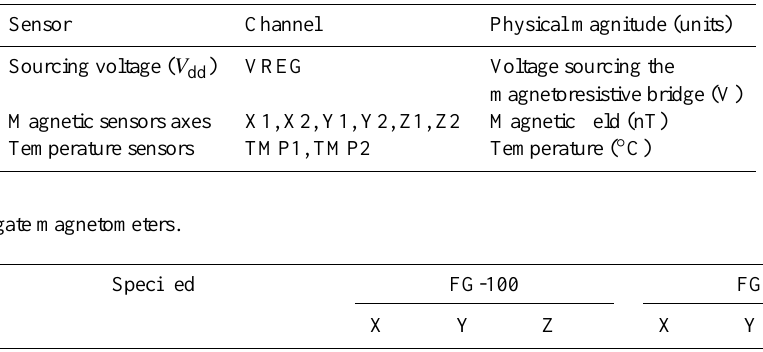
Table 3. Channels involved in the study.